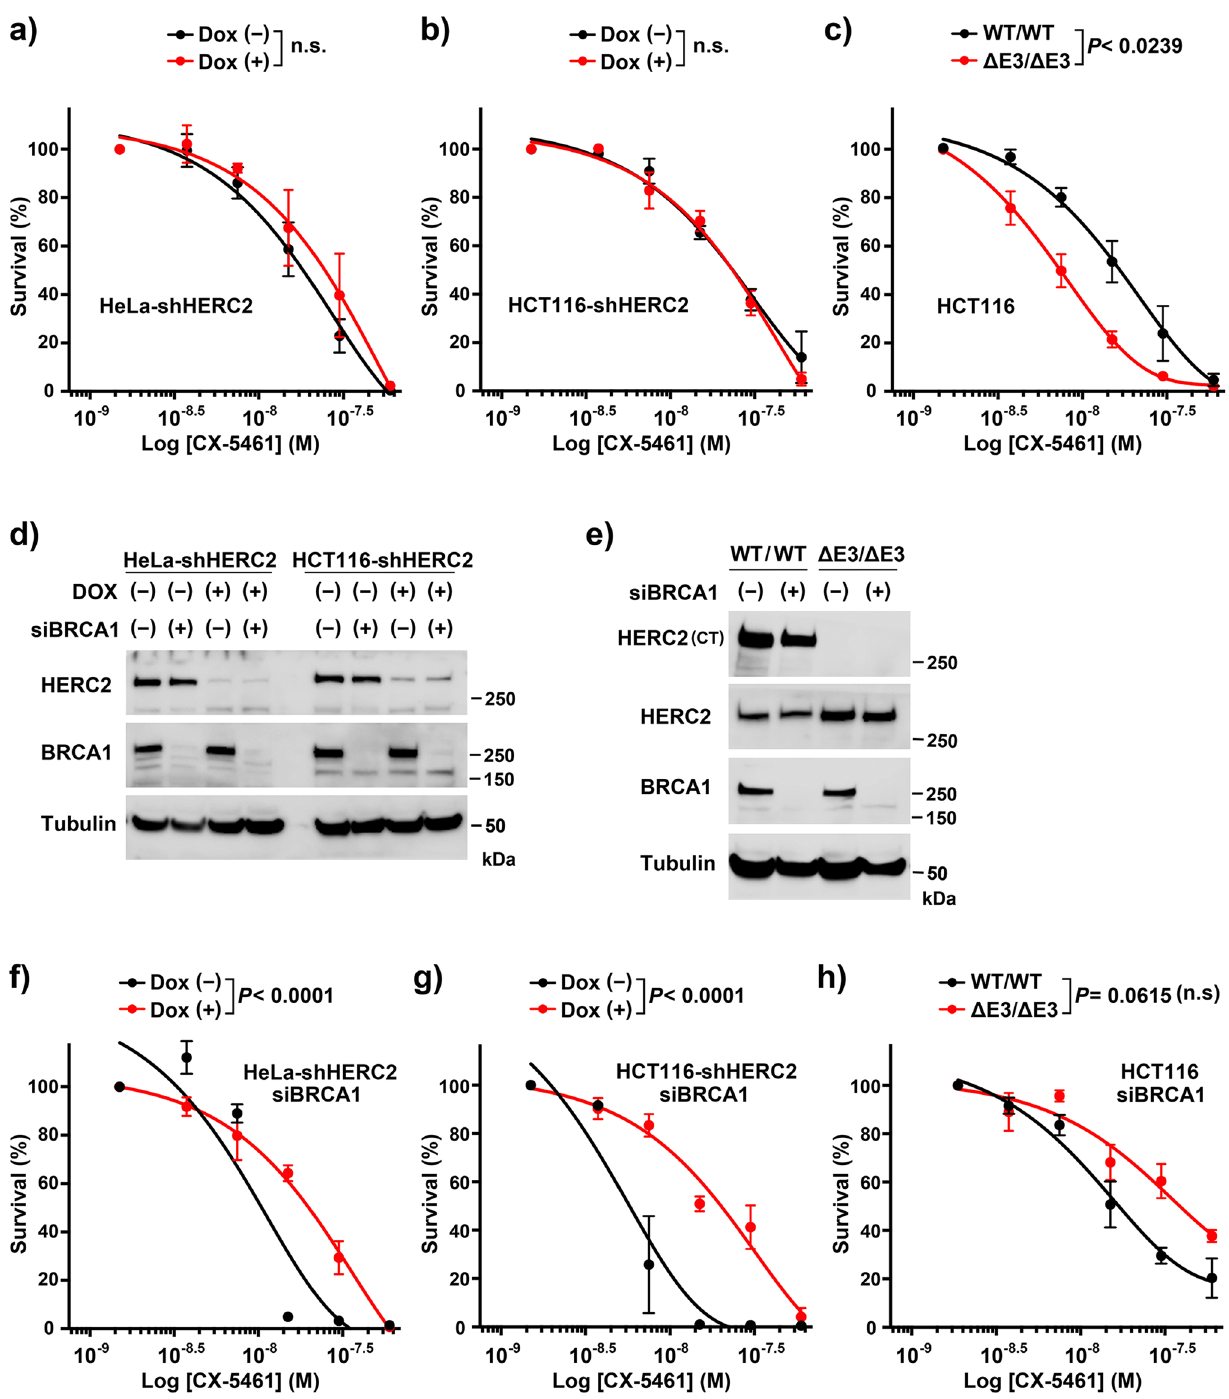
Figure 6. HERC2 dysfunction alters the sensitivity of cells to CX-5461. (a–c) HeLa-shHERC2 (a) and HCT116- shHERC2 (b) cells, with or without Dox-mediated induction, or WT or HERC2 ΔE3/ΔE3 HCT116 cells (c) were exposed to indicated doses of the CX5461 for 24 h and analyzed for clonogenic survival after two weeks. The data are shown with the nonlinear regression fit curves of one phase decay (GraphPad Prism). (d–h) Cells as in (a–c) were transfected with control (–) or BRCA1-specific siRNA, with or without Dox-mediated induction, and either subjected to immunoblotting with the indicated antibodies (d,e) or clonogenic survival assays ( f–h , and supplementary Figure S11) as in (a–c) . Average ± SD values, normalized to cells without agents were derived from three independent experiments. P -values of interactions were calculated using two-way ANOVA. The concentration that inhibited 50% of the colonies (IC50 value) was as follows: (a) Dox (−): 17.3 nmol/l, Dox ( +): 22.3 nmol/l, (b) Dox (−): 22.4 nmol/l, Dox ( +): 21.6 nmol/l, (c) WT/WT: 16.1 nmol/l, ΔE3/ΔE3: 7.3 nmol/l, (f) Dox (−): 10.0 nmol/l, Dox ( +): 18.3 nmol/l, (g) Dox (−): 6.1 nmol/l, Dox ( +): 18.1 nmol/l, (h) WT/WT: 17.8 nmol/l, ΔE3/ΔE3: 39.3 nmol/l. Full-length blots/gels are presented in Supplementary Figure